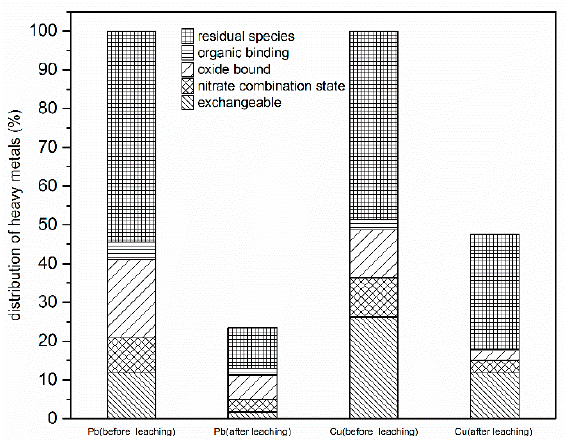
Figure 8. Speciation of metal ions on oil-contaminated soil before and after G- β -CD desorption.